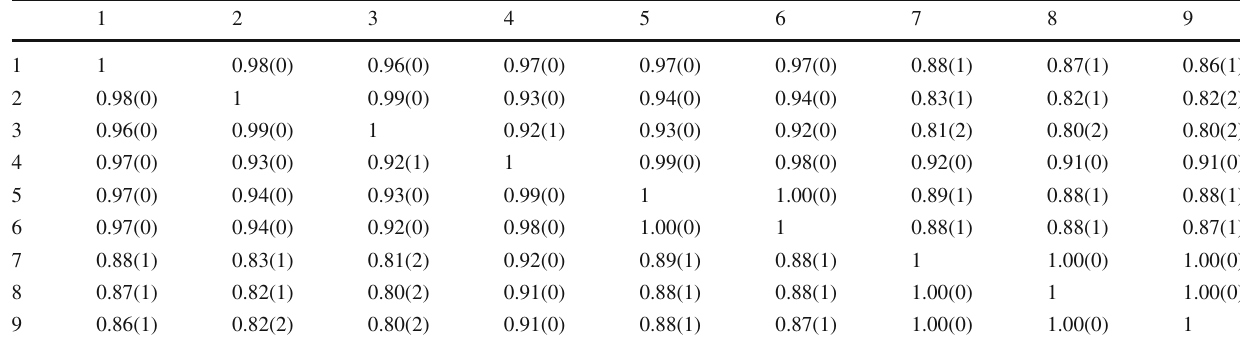
Table 7 Comparison of field theoretic definitions with GF smoothing and different smoothing actions and flow times. The numbers corre- spond to the numbering given in Fig. 15. We give the correlation coeffi-